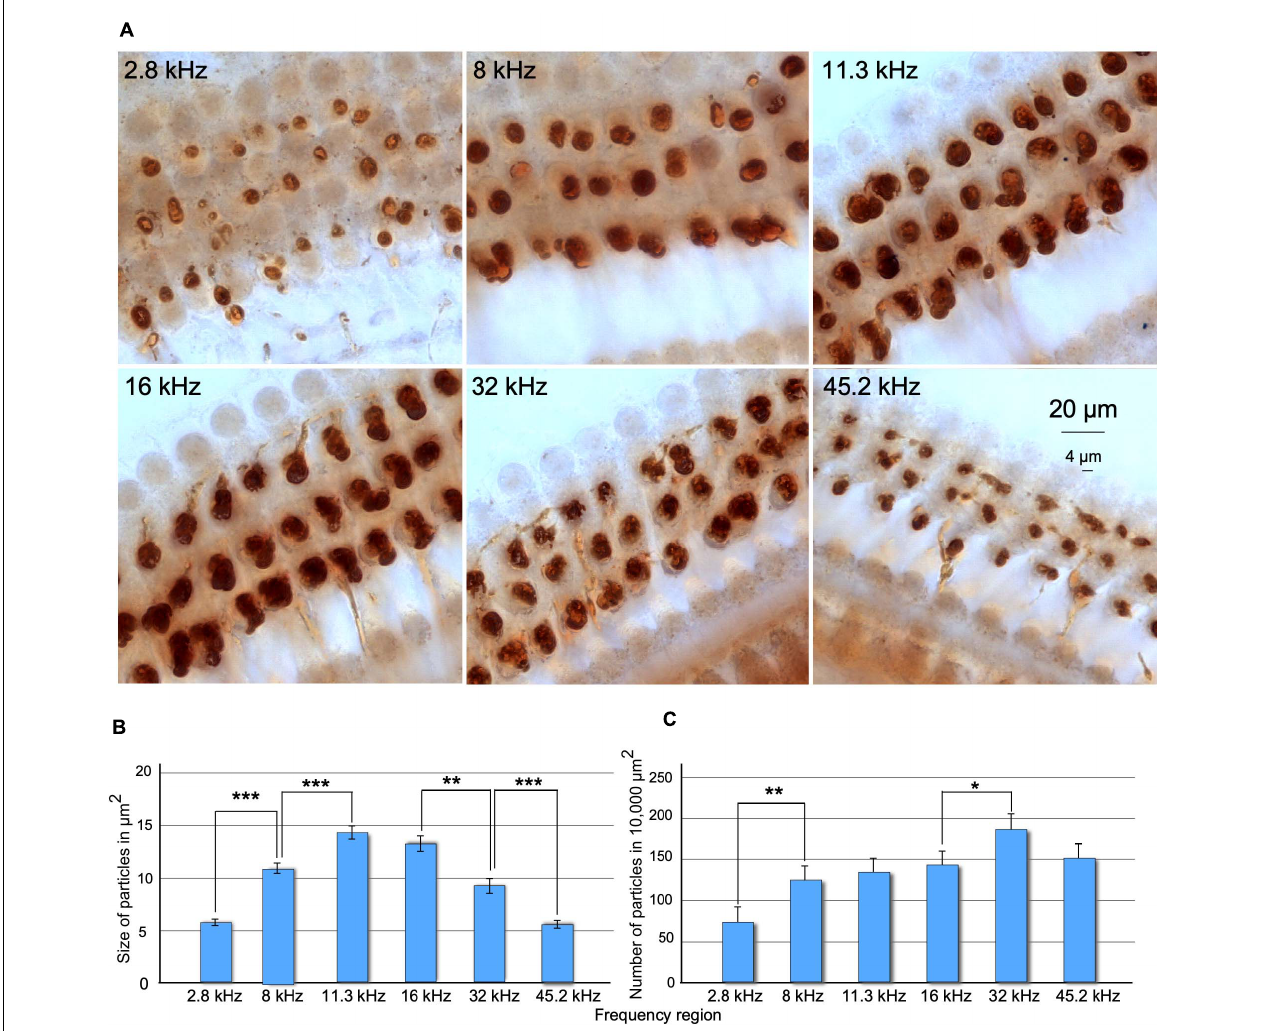
FIGURE 5 | (A) Comparison of changes in size and number of ChAT-immunostained terminal buttons along frequency regions of the cochlea in SCs. Images were acquired using a deep focus tool. (B) Statistical analysis of size of buttons upon density threshold segmentation. Note that the size of the terminals increases and decreases along the tonotopic axis of the cochlea. Significant differences were found when comparing each frequency region with the adjacent, except between 11.3 and 16 kHz regions. (C) Number of terminals measured by density threshold segmentation normalized to 10,000 µ m 2 . The lower significant number of the terminals was found at 2.8-kHz areas and the highest at 32-kHz areas. After comparing adjacent frequency regions, significant differences were found between 2.8 and 8 kHz and 16 and 45 kHz (* p > 0.05, ** p < 0.01, *** p <